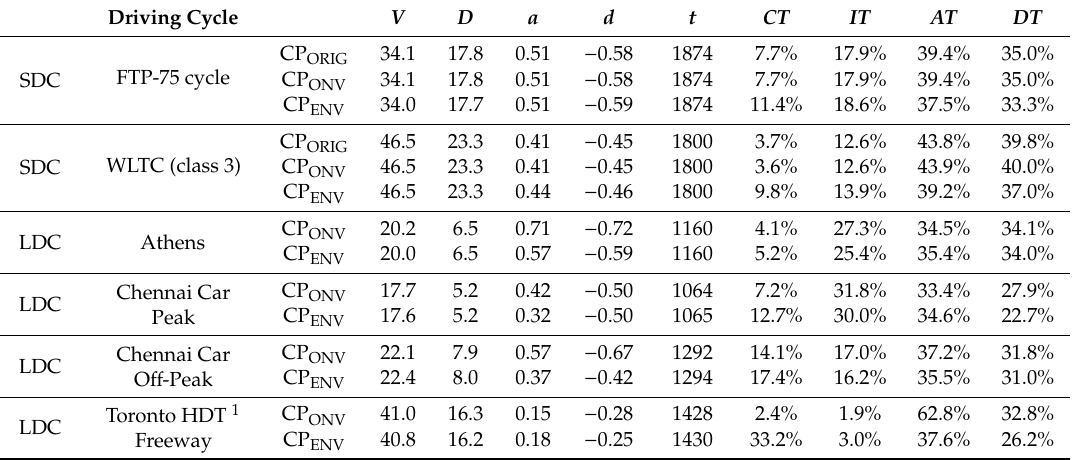
Table 6. Validation